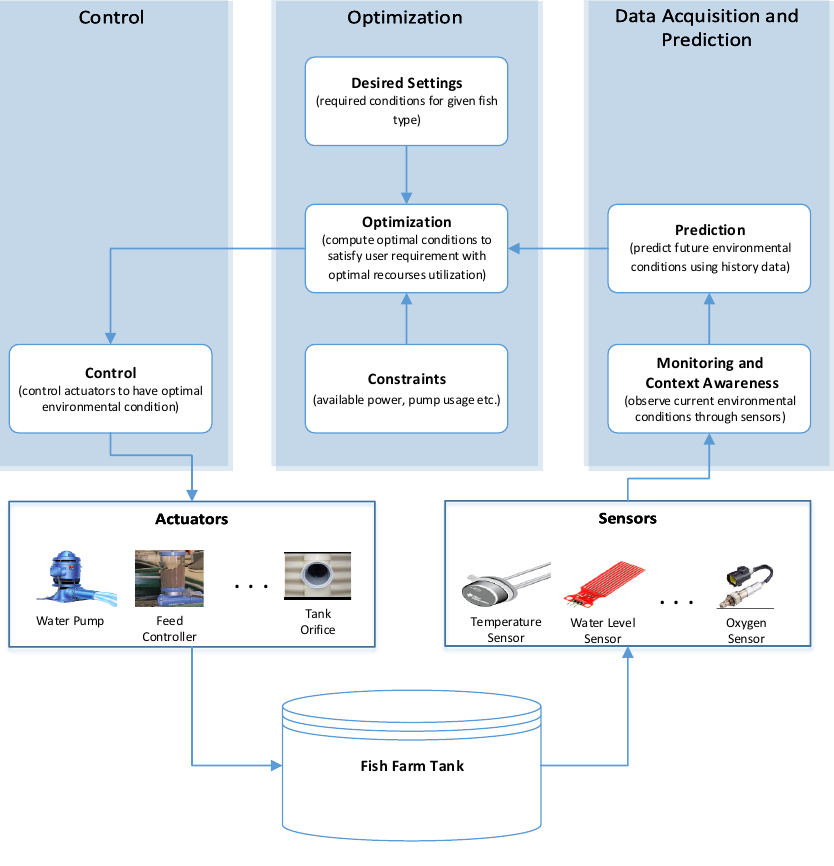
Figure 2. Proposed conceptual design for IoT based fish